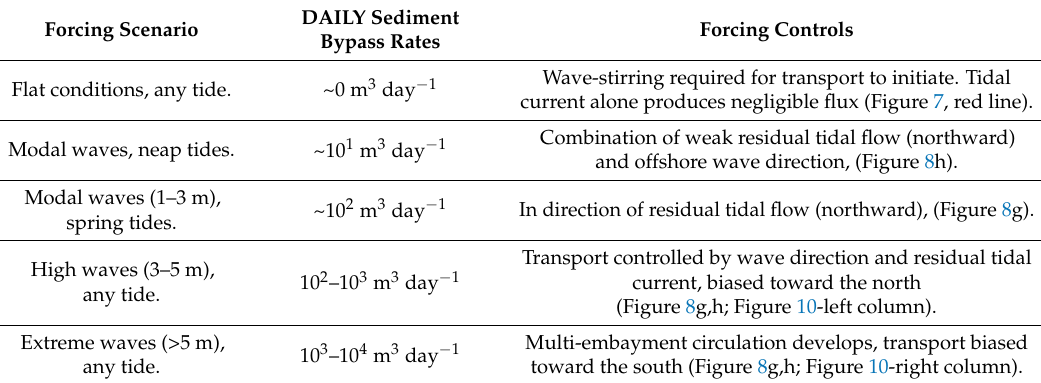
Forcing Controls